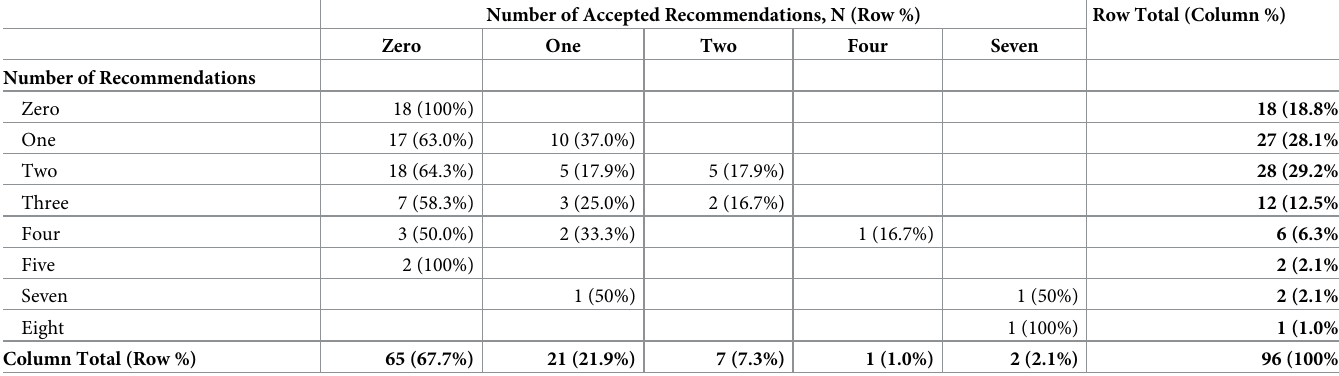
Table 2. Recommendations from pharmacist medication review and acceptance by home-based primary care